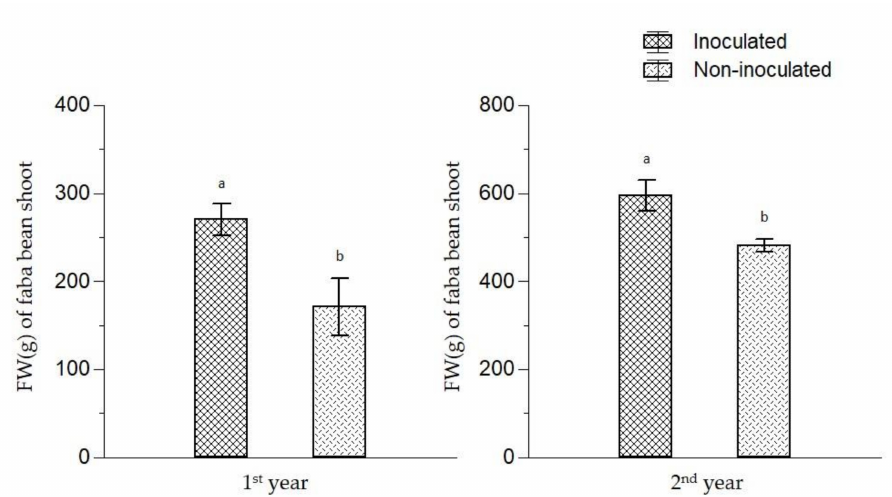
Figure 3. Impact of faba bean inoculation with Rhizobium laguerreae VFLE1 on shoot fresh weight (SFW) at the 50% flowering stage during the 1st and 2nd winter cultivation period. For each cultivation period, di ff erent letters at each bar indicate significant di ff erences according to Duncan’s multiple range test ( p < 0.05). Vertical bars indicate standard errors of means (n =